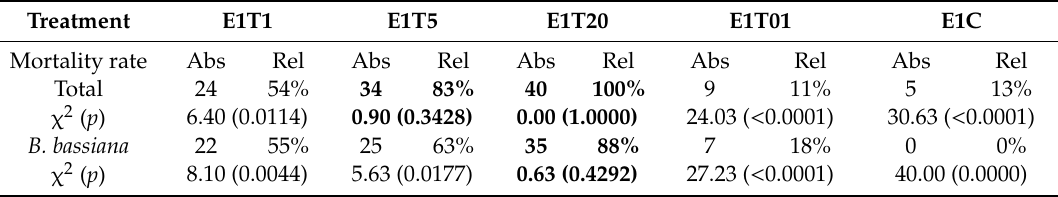
Table 3. Total and B. bassiana attributed absolute and relative mortality rates with Abbott’s correction for treatments in experiment set 1 and corresponding results of a Chi-square test. Values that are not significantly di ff erent from LD100 are highlighted in bold, and values for which H0 cannot be accepted nor rejected are depicted in